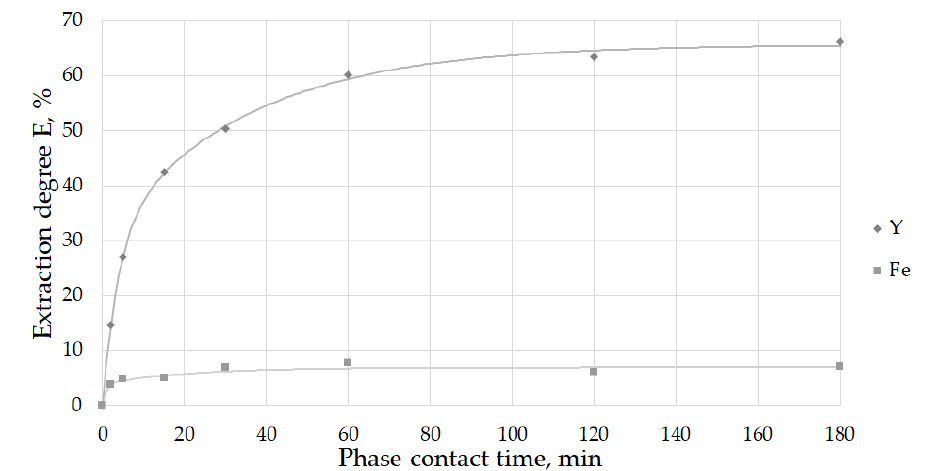
Figure 15. The dependences of the iron (III) and yttrium extraction degree from industrial phosphoric acid solution on the phase contact time.